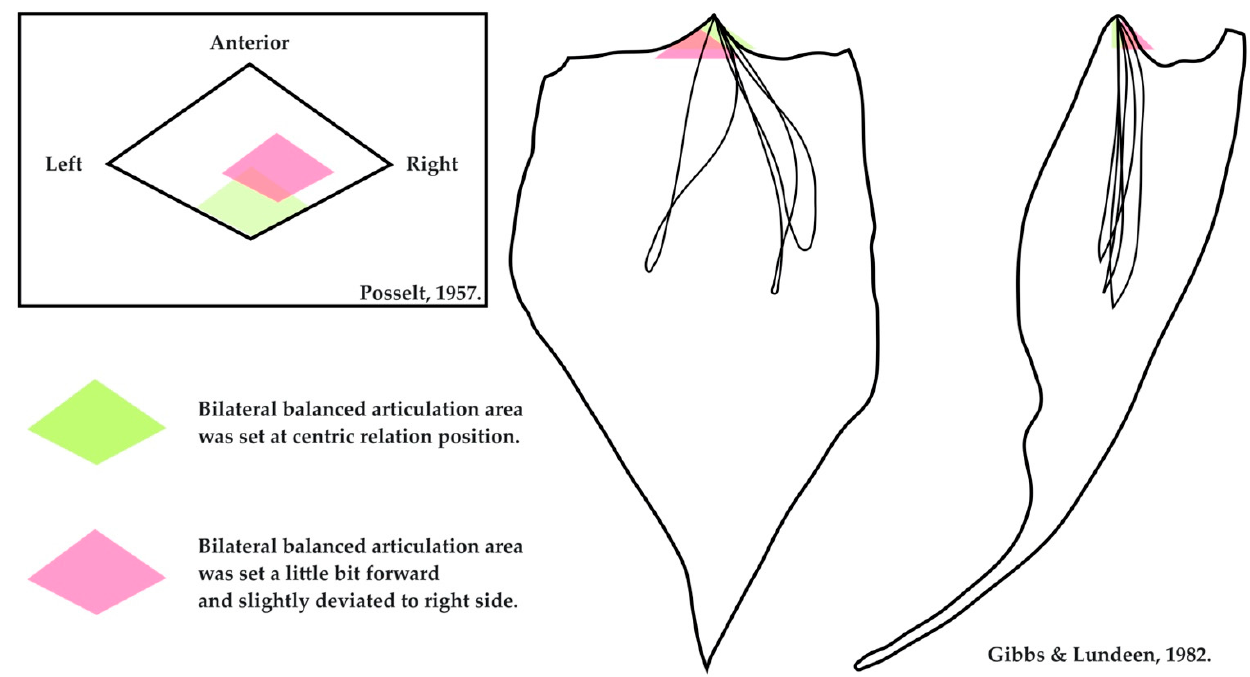
Figure 2. Diagram showing the advantage of setting the occlusion and articulation of dentures in the centric relation. The original figures come from Posselt and Gibbs and Lundeen [44,45].